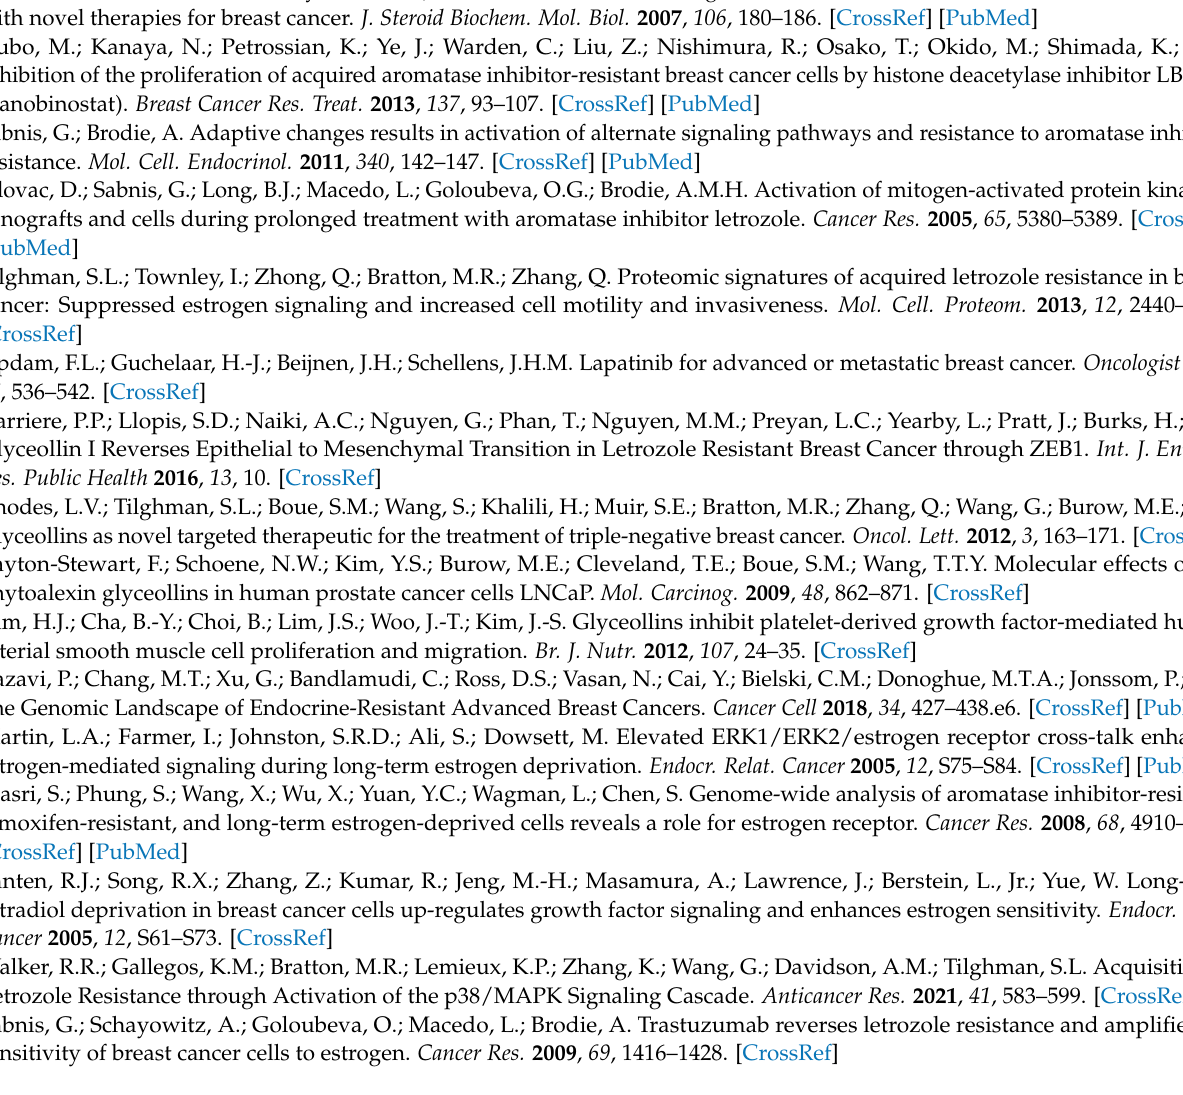
Figure A2. Glyceollin ± lapatinib does not alter the expression of MAPK or HER-2. Both cell lines were cultured in standard growth media and treated for 24 h with DMSO vehicle control, 0.5 μM lapatinib, 10 μM glyceollin, or 0.5 μM lapatinib 10 μM glyceollin as described in the methods section. Western blot analyses were performed to examine the expression of ( a ) MAPK and ( b ) HER-2. Student’s “t” tests were performed, and treatments were compared to the control. Densitometry was conducted as previously described. Representative images of the blots are shown below the graphed values.